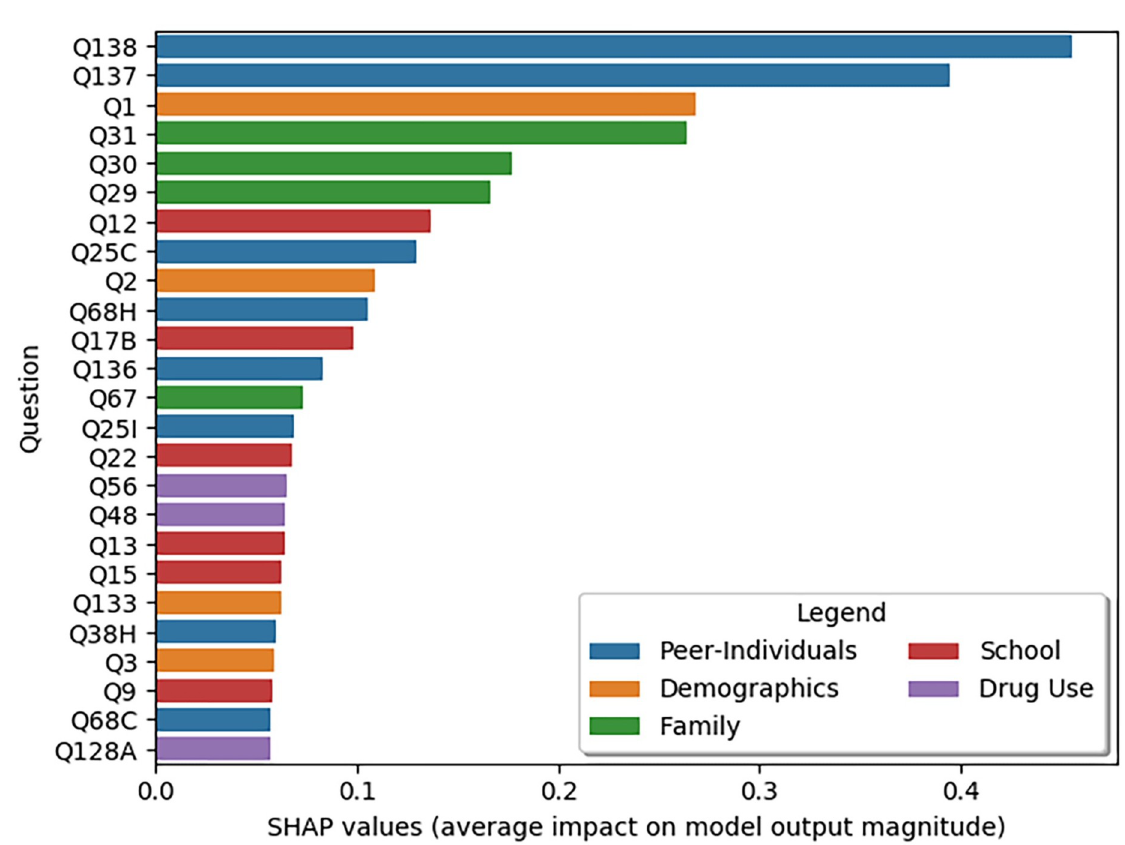
Fig 3. SHAP plots showing feature importance for predicting STB. Note that scores are relative to this particular dataset, with larger scores indicating higher influence.